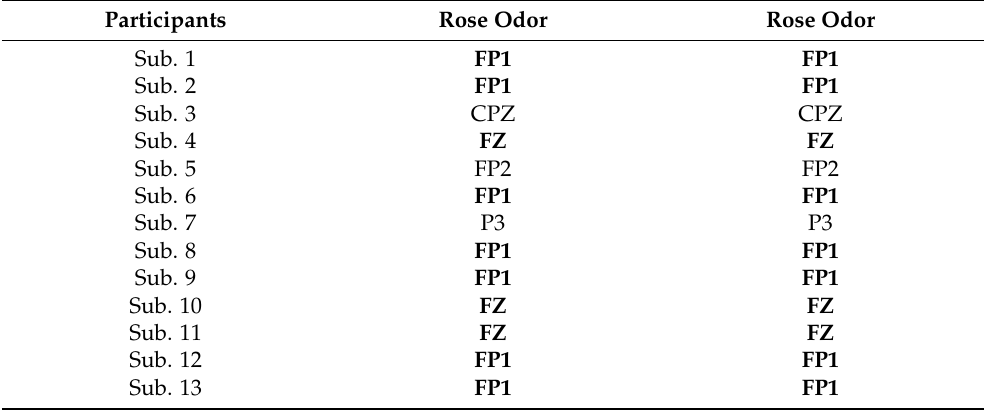
Table 3. Electrodes corresponding to the maximum PSD amplitudes of each odor type. Participants Rose Odor Rose